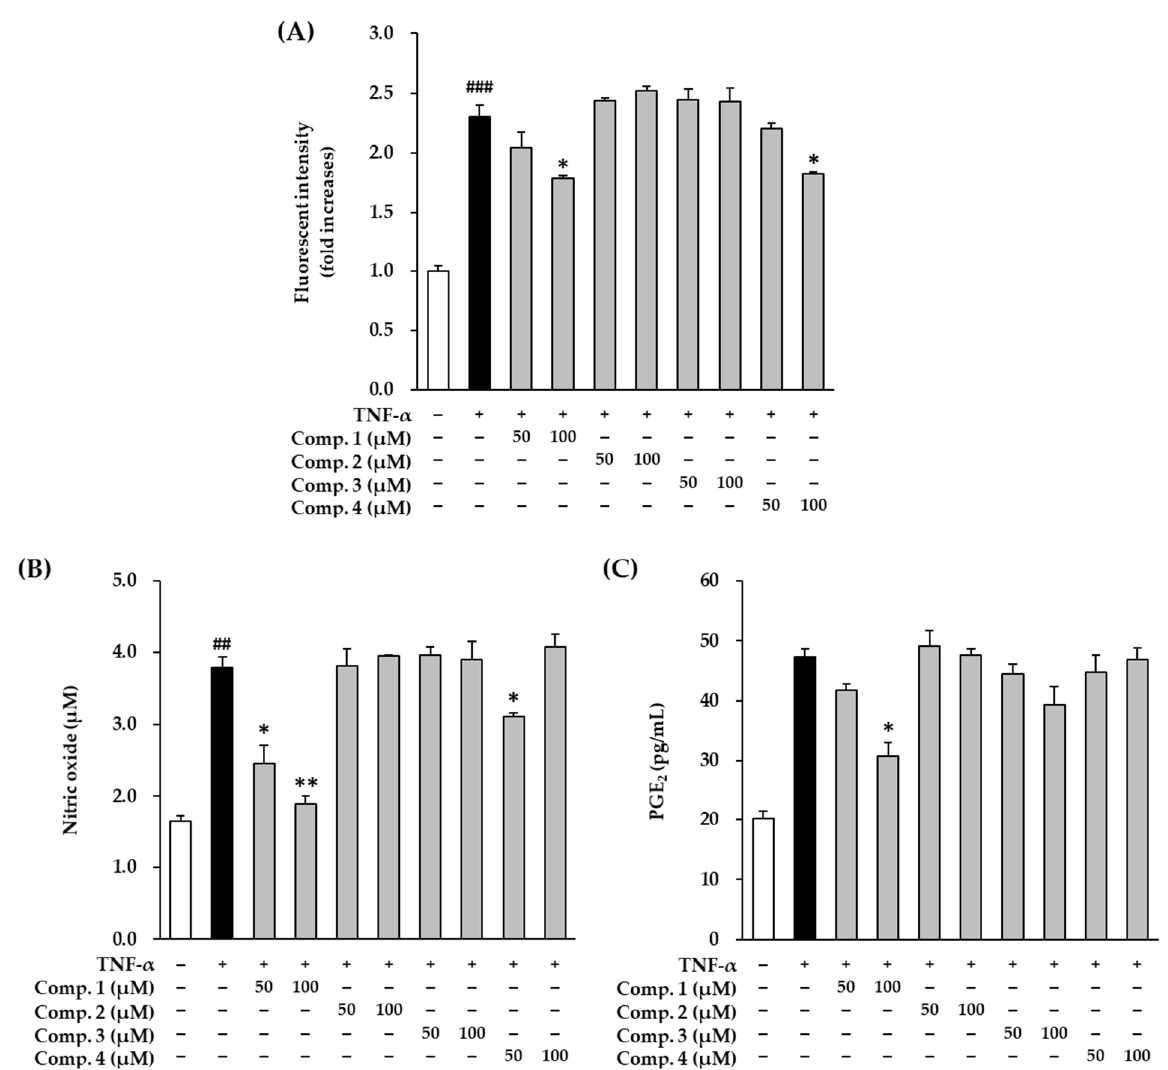
Figure 2. Effects of 1,3-dihydroxy-2,8-dimethoxy-6-methylanthraquinone ( 1 ), 1-hydroxy-2,3,8- trimethoxy-6-methylanthraquinone ( 2 ), 1,2-dihydroxy-3,8- dimethoxy-6-methylanthraquinone ( 3 ) and evariquinone ( 4 ) on production of intracellular ROS, proinflammatory mediators NO and PGE 2 in TNF- α -stimulated HDFs. HDFs were untreated or exposed to TNF- α , followed by treatment with 1 – 4 for 24 h. The levels of ( A ) ROS and ( B ) NO and ( C ) PGE 2 were determined using DCFDA dye, Griess reaction assay, and ELISA. The data are presented as mean ± SEM of at least three independent experiments. ## p < 0.01 and ### p < 0.001 difference compared to untreated cells. * p < 0.05 and ** p < 0.01 difference compared to TNF- α -stimulated cells.